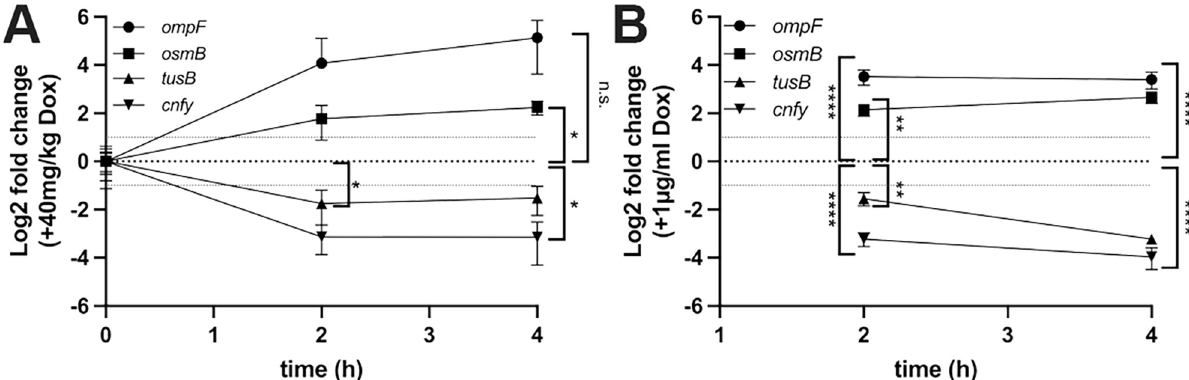
Fig 2. ompF , osmB , CNFy , and tusB are differentially regulated in response to doxycycline in vivo . (A) C57BL/6 mice were infected with WT Y . pseudotuberculosis , infection proceeded for 48h (hours, h), and mice were injected intraperitoneally with a single dose of 40mg/kg Dox. At the indicated timepoints spleens were harvested, and samples were enriched for bacterial RNA prior to qRT-PCR. Time: h post-treatment, 0h represents 48h post- inoculation (p.i.), the time of treatment. Log2 fold change is relative to 0h. Horizontal dotted lines depict average values for 0h (0log2), and 2-fold changes. Data represents 4 biological replicates/group. (B) Cultures of WT Y . pseudotuberculosis were incubated for 4h in the presence or absence of 1 μ g/ml Dox, bacterial RNA was isolated and transcripts were detected by qRT-PCR. Log2 fold change values were calculated relative to untreated cells, horizontal dotted lines depict average values for untreated cells (0log2), and 2-fold changes. Data represents four biological replicates. Statistics: ( A) Two-way ANOVA with Bonferroni’s multiple comparison test, comparisons made relative to 48h p.i./time 0h timepoint. (B) Two-way ANOVA with Tukey’s multiple comparison test, comparisons made relative to untreated cells using relative expression values. ���� p < .0001, ��� p < .001, �� p < .01, � p < .05, n.s.: not